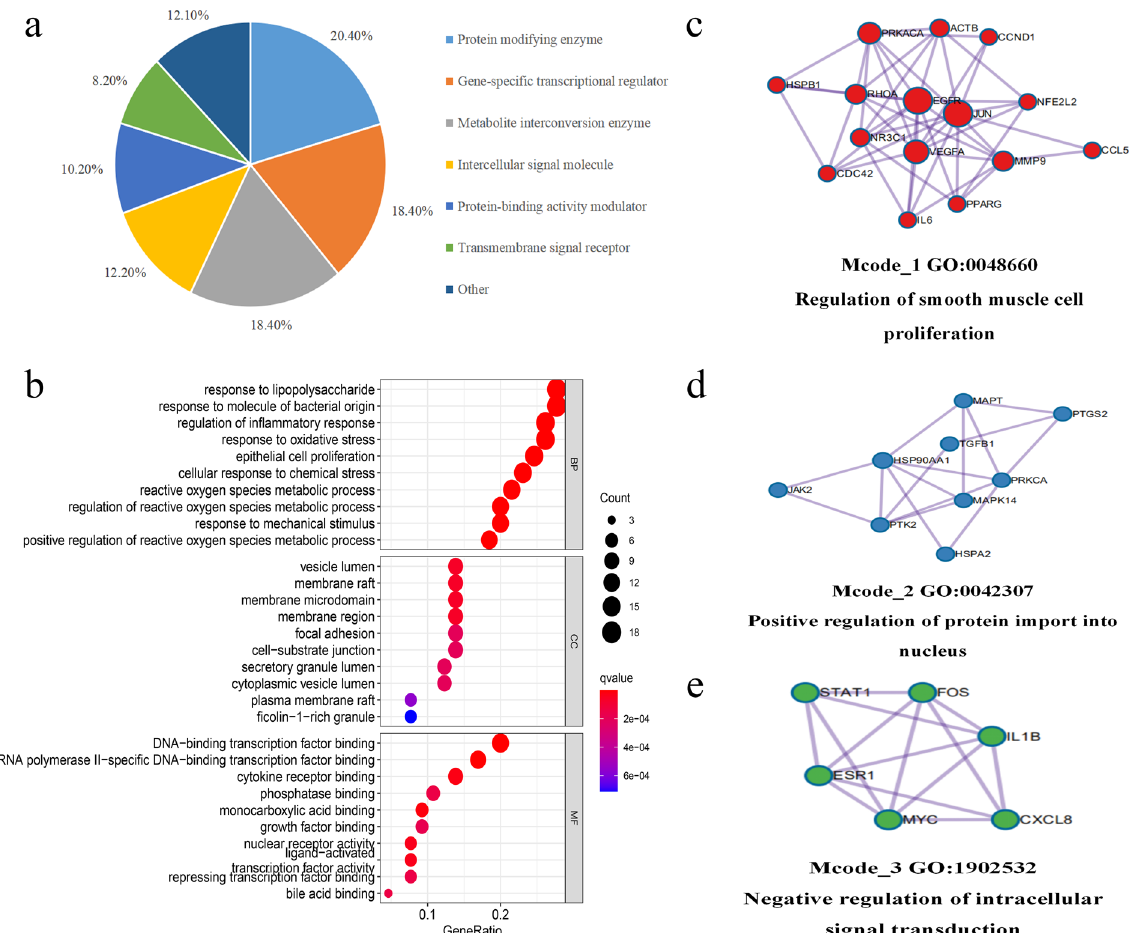
Figure 3. Bioinformatics analysis of target proteins of Que against AF. ( a ) Panther classification categorized target proteins of Que against AF. The figures next to the pie chart indicate the percentage of protein in the given functional class. ( b ) GO, BP, CC and MF enrichment analysis of interselection targets. The intensity of the color represents the adjusted p value, and the bubble size corresponds to the number of genes. ( c – e ) The Molecular Complex Detection (MCODE) algorithm has been used to identify densely connected network